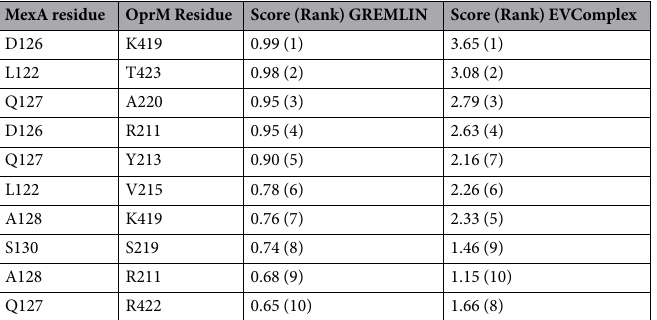
Table 1. Top ten predicted covarying residue pairs between MexA and OprM by GREMLIN and EVComplex. Gremlin scores are expressed as probabilities that predicted residue pairs are covarying and interacting, with values ≥ 0.70 giving high-confidence predictions. For EVComplex, the scores are not expressed as probabilities, and values > 0.8 are predicted to be co-varying and interacting. Values in parentheses show the ranking of each residue pair by either